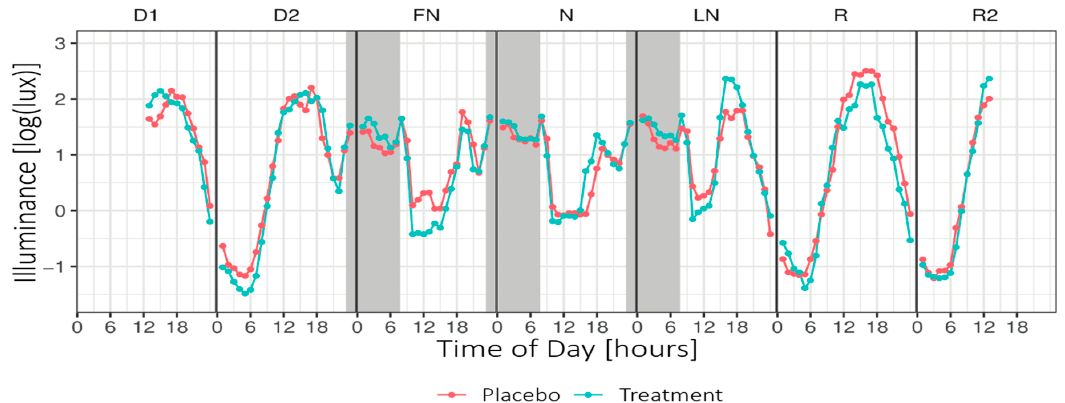
Figure 4. Mean hourly illuminance (log-transformed) across Daytype. Grey areas indicate nightshift work (~23:15–07:45). Note that the data presented in this plot were not adjusted for the transmission of the blue-blocking goggles and do not include light exposure from the light glasses. D1 = first day before nightshift, D2 = second day before nightshift, FN = first night of nightshift, N = nightshift, LN = last night of nightshift, R = first recovery day, and R2 = second recovery day.